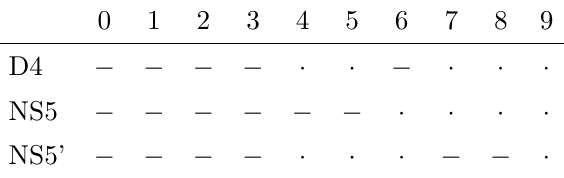
Table 2 . IIA configuration of D4-branes, NS5-branes and